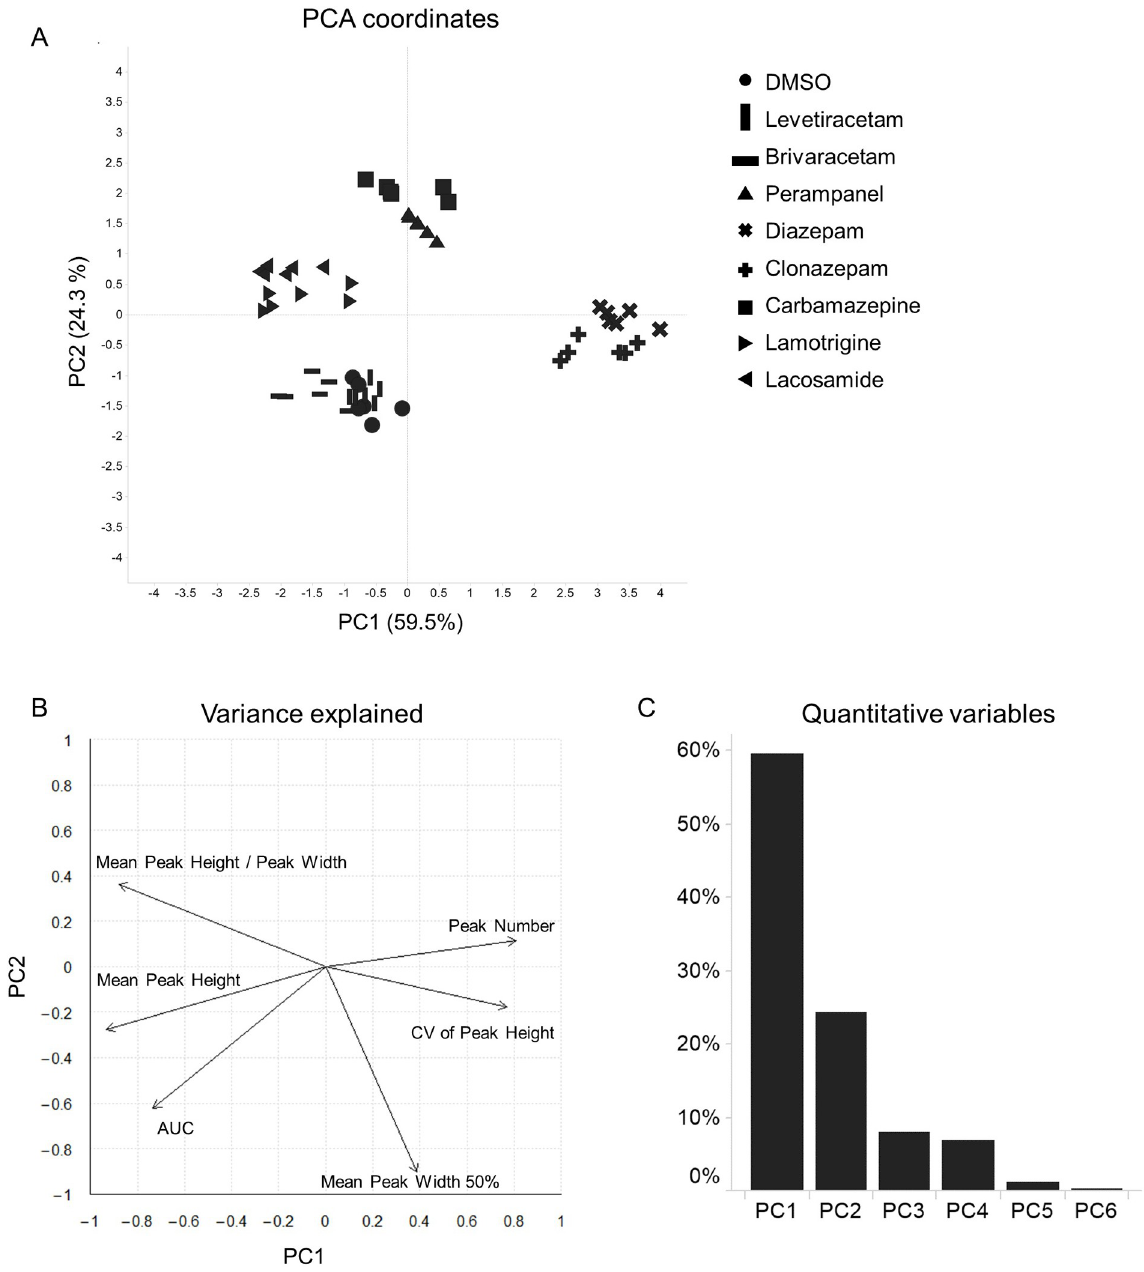
Fig 3. PCA coordinates and contribution plots in response to treatment with AEDs. (A) PCA of wave features. The individual wells are plotted. Different AEDs are represented by different shapes. (B) Plot depicting the contribution of features to PC1 and PC2 (arrows). (C) Bar plots displaying the percentage of variance explained by each